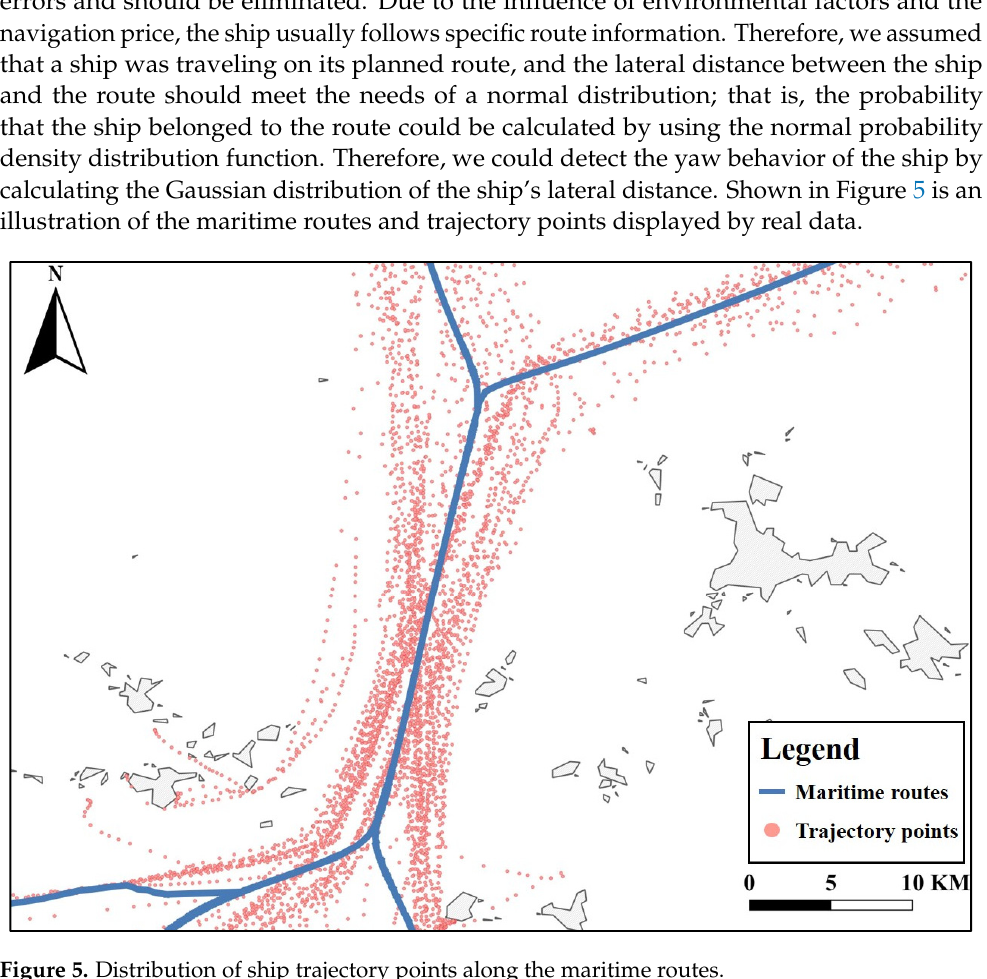
Figure 5. Distribution of ship trajectory points along the maritime routes.